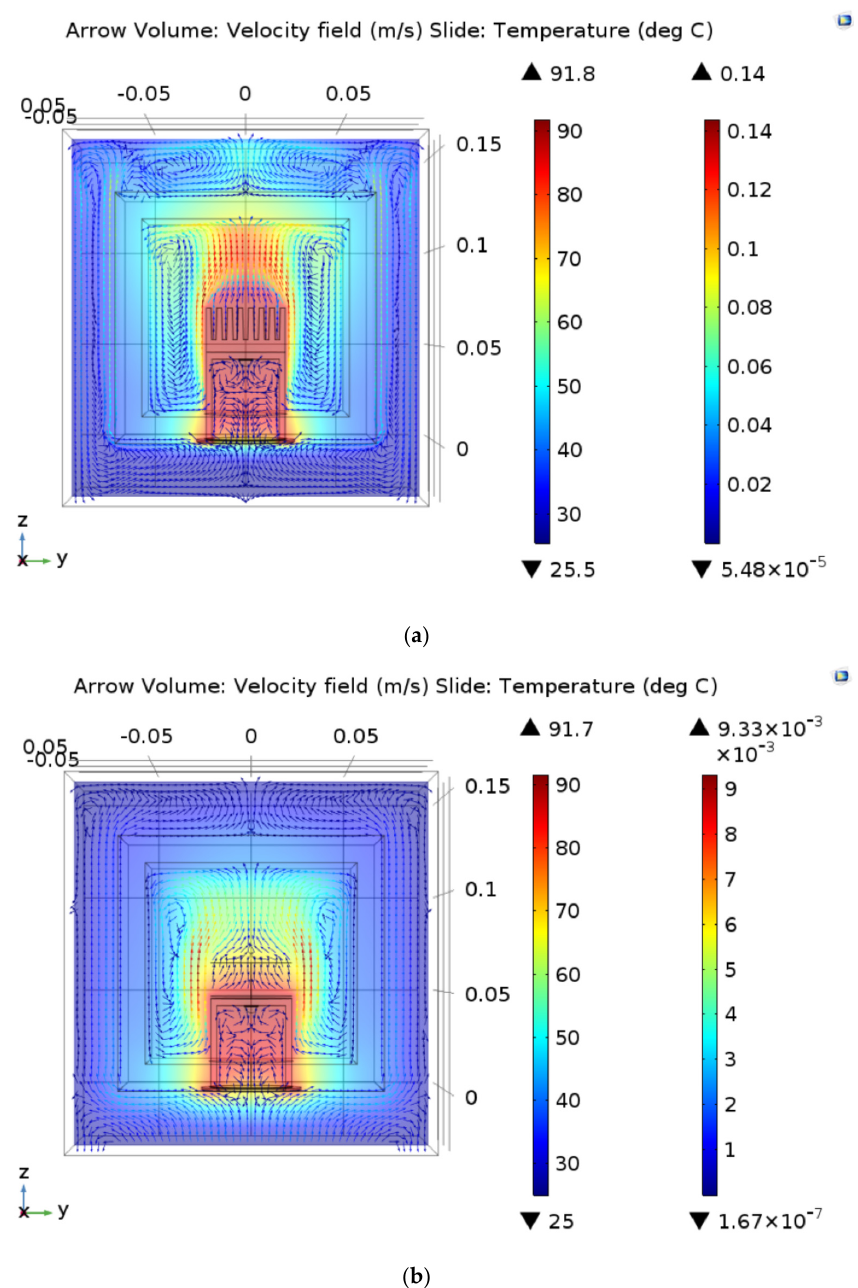
Figure 7. Simulation results of temperature and fluid flow velocity fields (view of yz plane) after INST. ( a ) with mounted ALFHS, and ( b ) with mounted CUFHS.